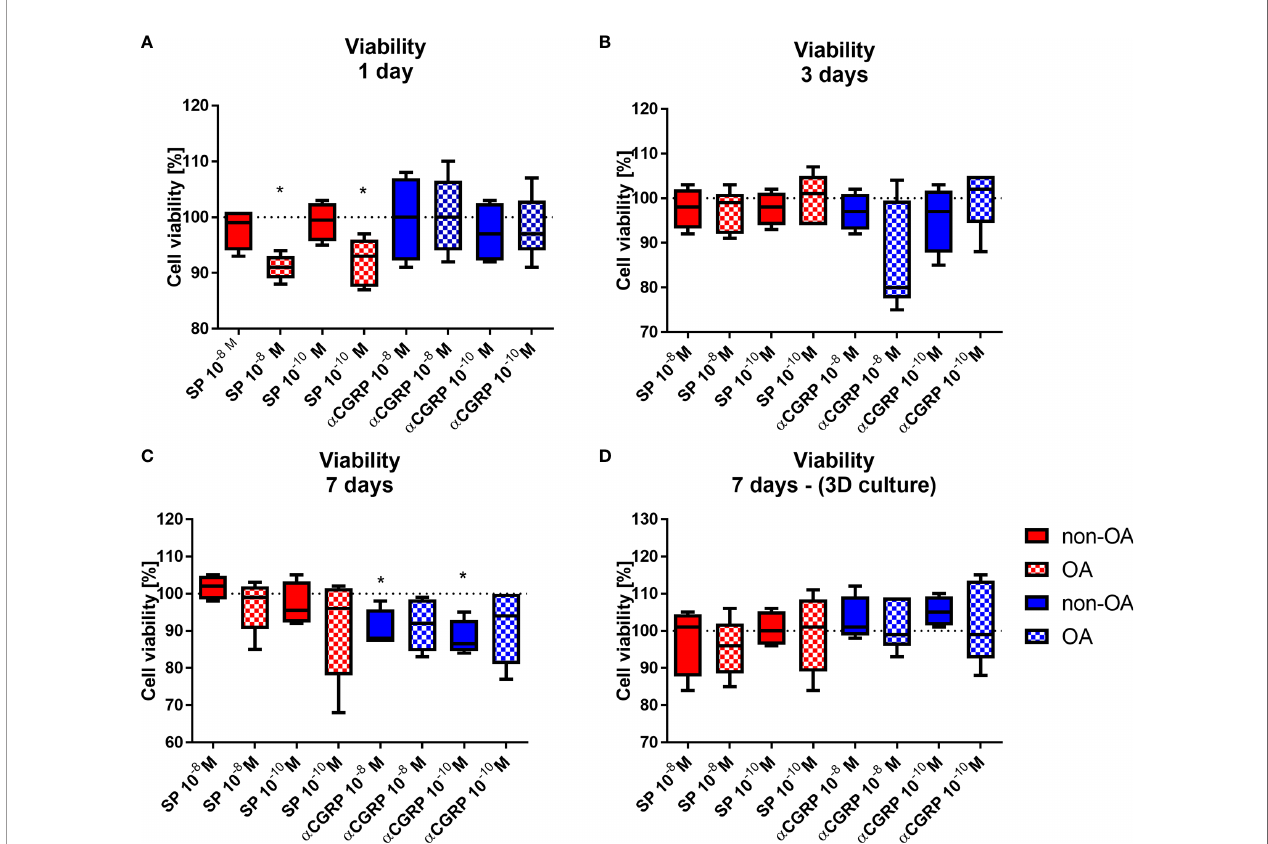
FIGURE 2 | Effects of SP and a CGRP stimulation on viability of OA and non-OA chondrocytes. Chondrocytes were treated with either 10 -8 or 10 -10 M SP or a CGRP and then compared with the respective untreated control cells (untreated controls set to 100% = dotted line). Viability was determined in monolayer culture after 1 day (A) , 3 days (B) and 7 days (C) . (D) Viability was determined in 3D fi brin gel culture after 7 days. Results show median (min to max); one sample t-test; *p ≤ 0,05; n =